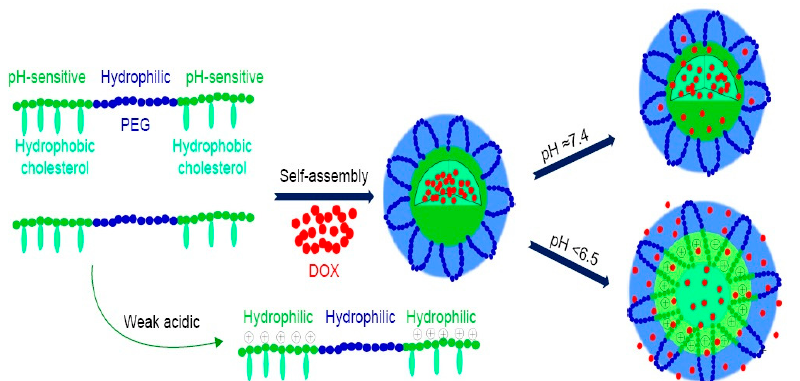
Figure 6. Schematic illustration of an example of self-assembled pH-responsive doxorubicin loaded micelles. The micelles were formulated using hydrophilic PEG and hydrophobic pH-sensitive PAE. The micelles will remain stable at normal sites (pH = 7.4), only to respond at the targeted site with the desired pH (pH < 6.5). Abbreviations: PEG—poly(ethylene glycol), PAE—poly( β -amino esters) g-cholesterol, and DOX—doxorubicin. Adapted and modified with permission from [92].